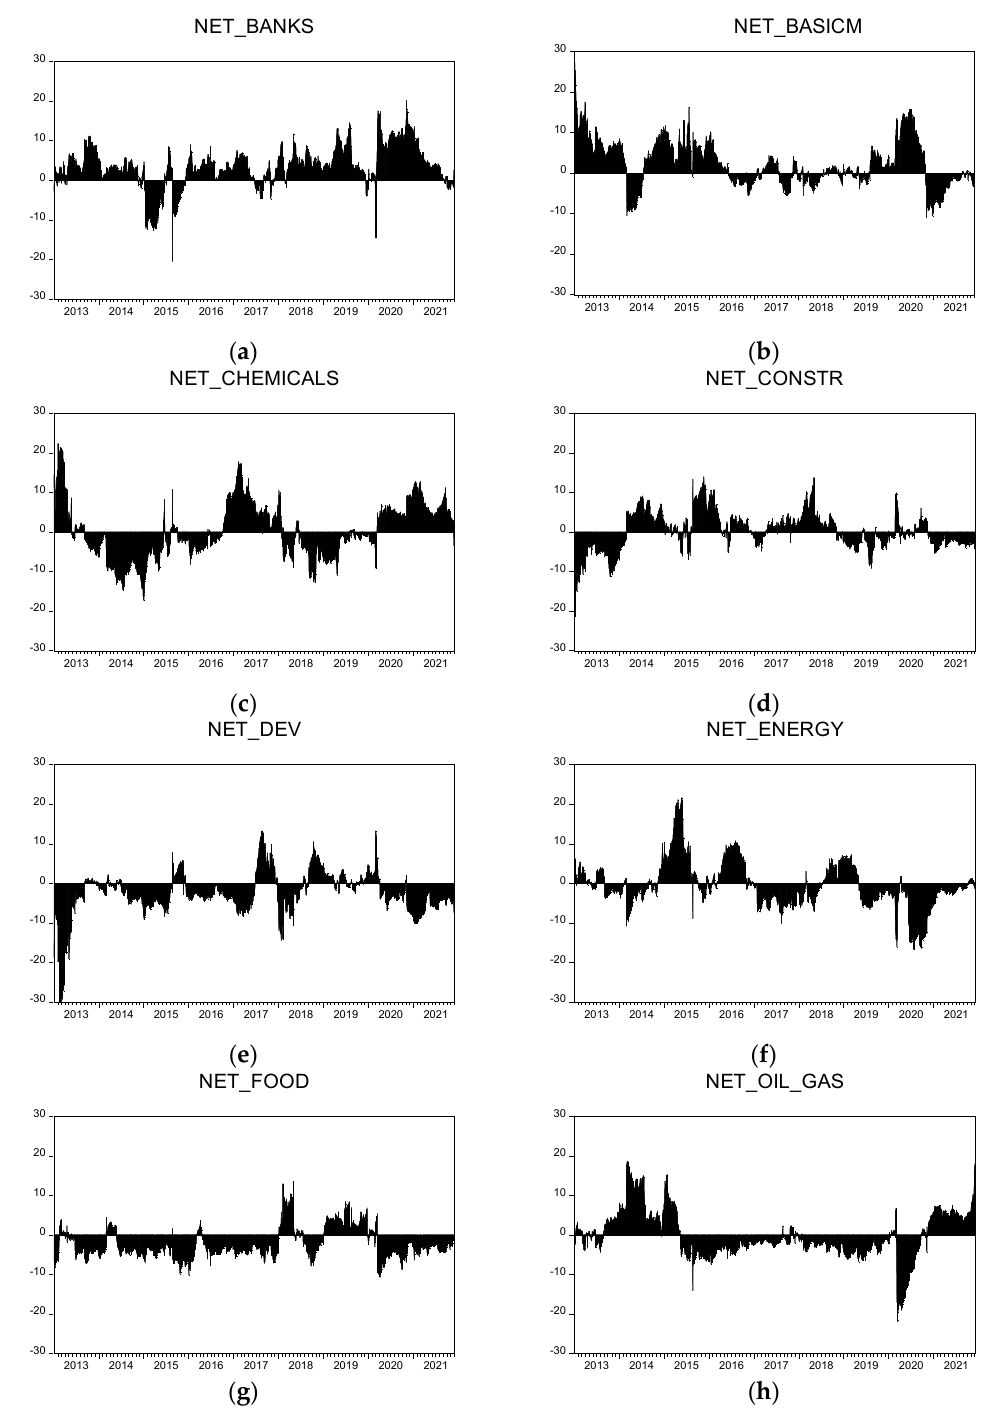
Figure 6. Net volatility spillovers for sectors in the Polish stock market in the period 1 January 2013–2 December 2021. Note: ( a ) Banks ( b ) Basicm, ( c ) Chemic, ( d ) Constr, ( e ) Dev, ( f ) Energy, ( g ) Food and ( h ) Oil_Gas represent the sectors banks, basic materials, chemicals, construction, developers, energy, food, and oil and gas, respectively. The results were obtained by the